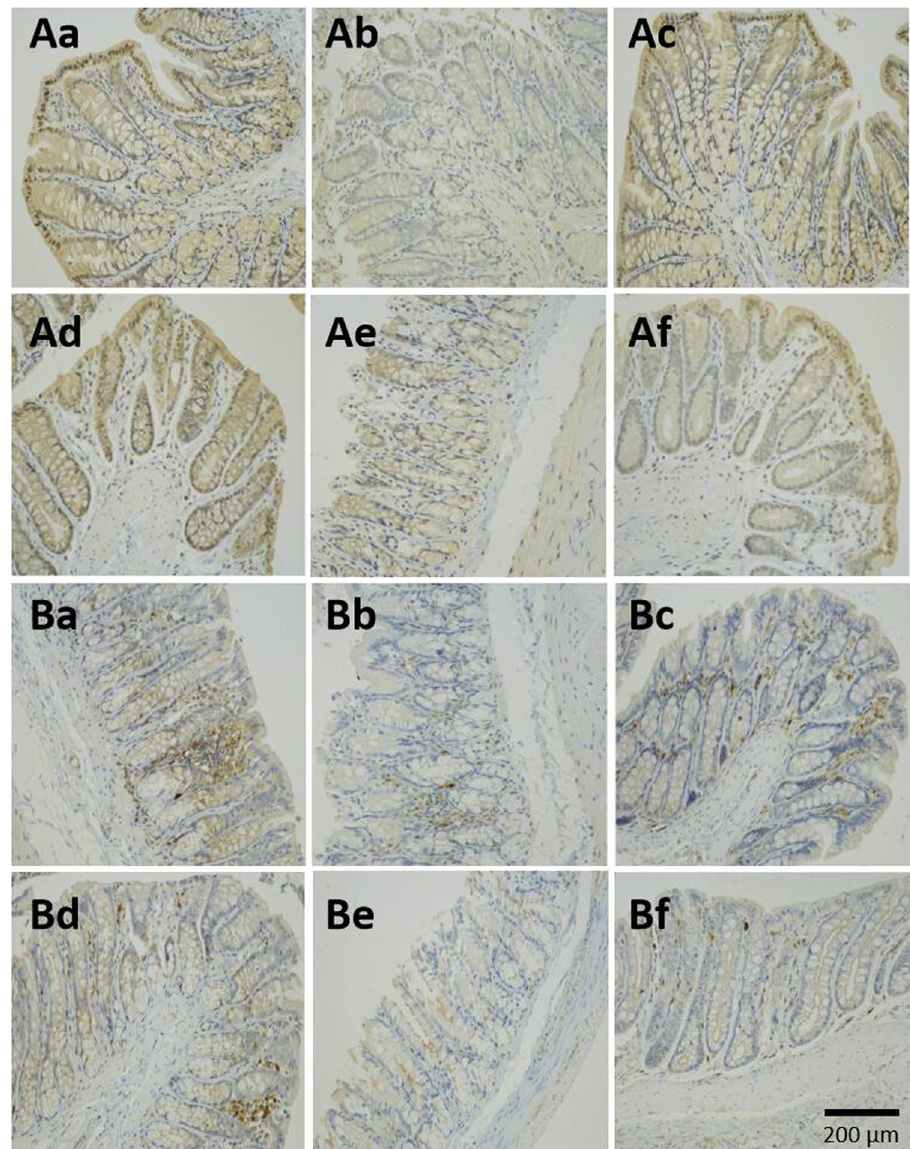
Fig. 7 Immunohistochemical analysis of the tight junction proteins occludin and ZO-1 in the rat colon. A Occludin; B ZO-1; a Normal; b Model; c SOD; d L-SOD; e SOD hydrolysate; f Positive